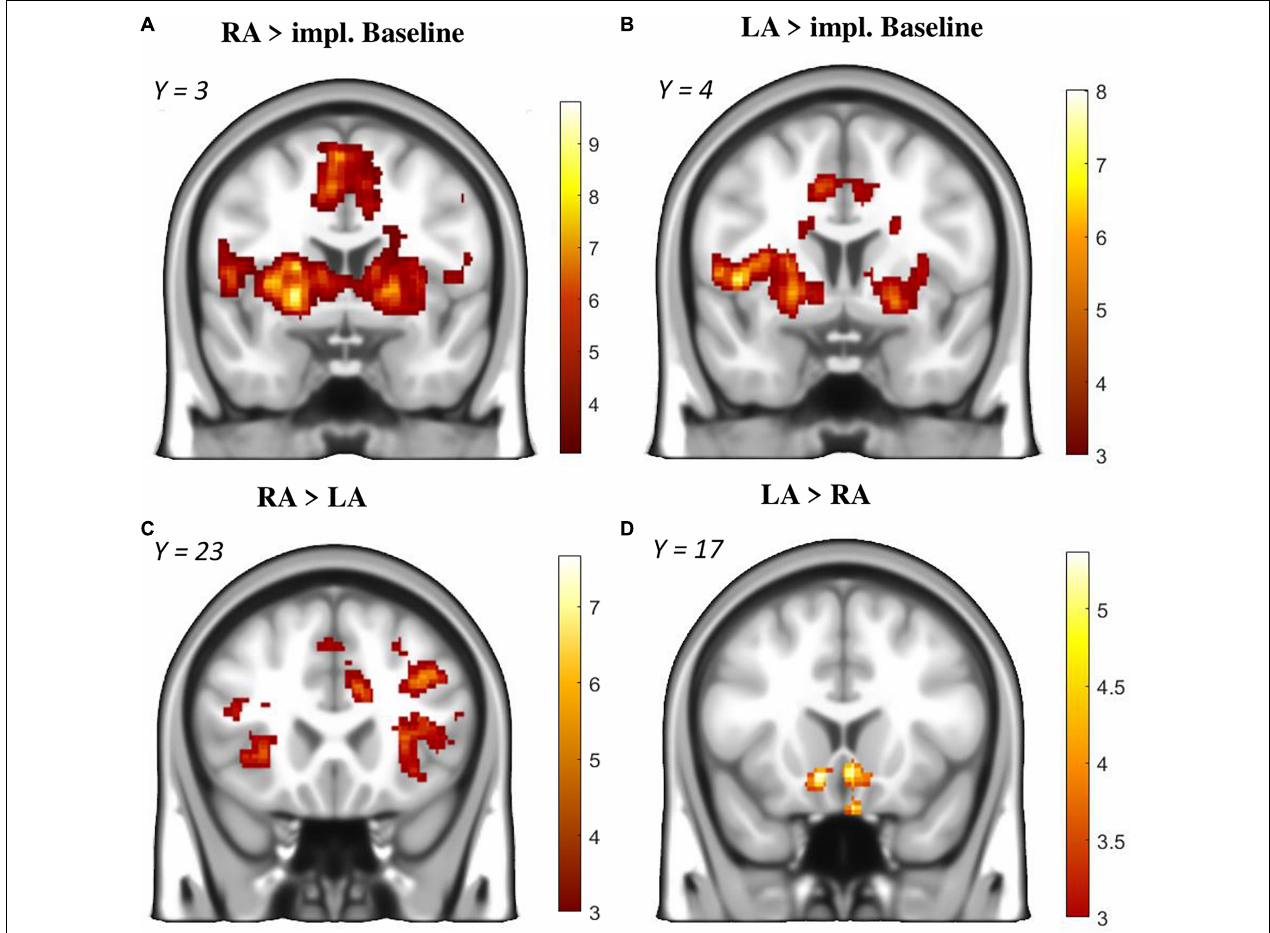
FIGURE 4 | Brain activation during the anticipation phase (monetary incentive delay task). (A) : Reward Anticipation (RA) > Implicit Baseline. (B) : Loss Anticipation (LA) > Implicit Baseline. (C) : RA > LA. (D) : LA > RA. Only voxels from significant clusters (cluster-size p < 0.05 corrected for multiple testing and p < 0.001 as cluster-defining threshold) are